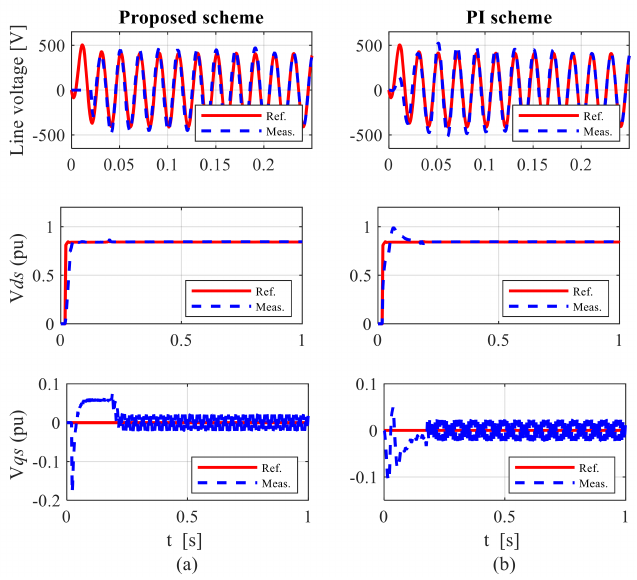
Figure 12. Control performances during super-synchronous speed operation under unbalanced grid conditions for R r(perturbed) = 150% R r : ( a ) proposed scheme and ( b ) PI